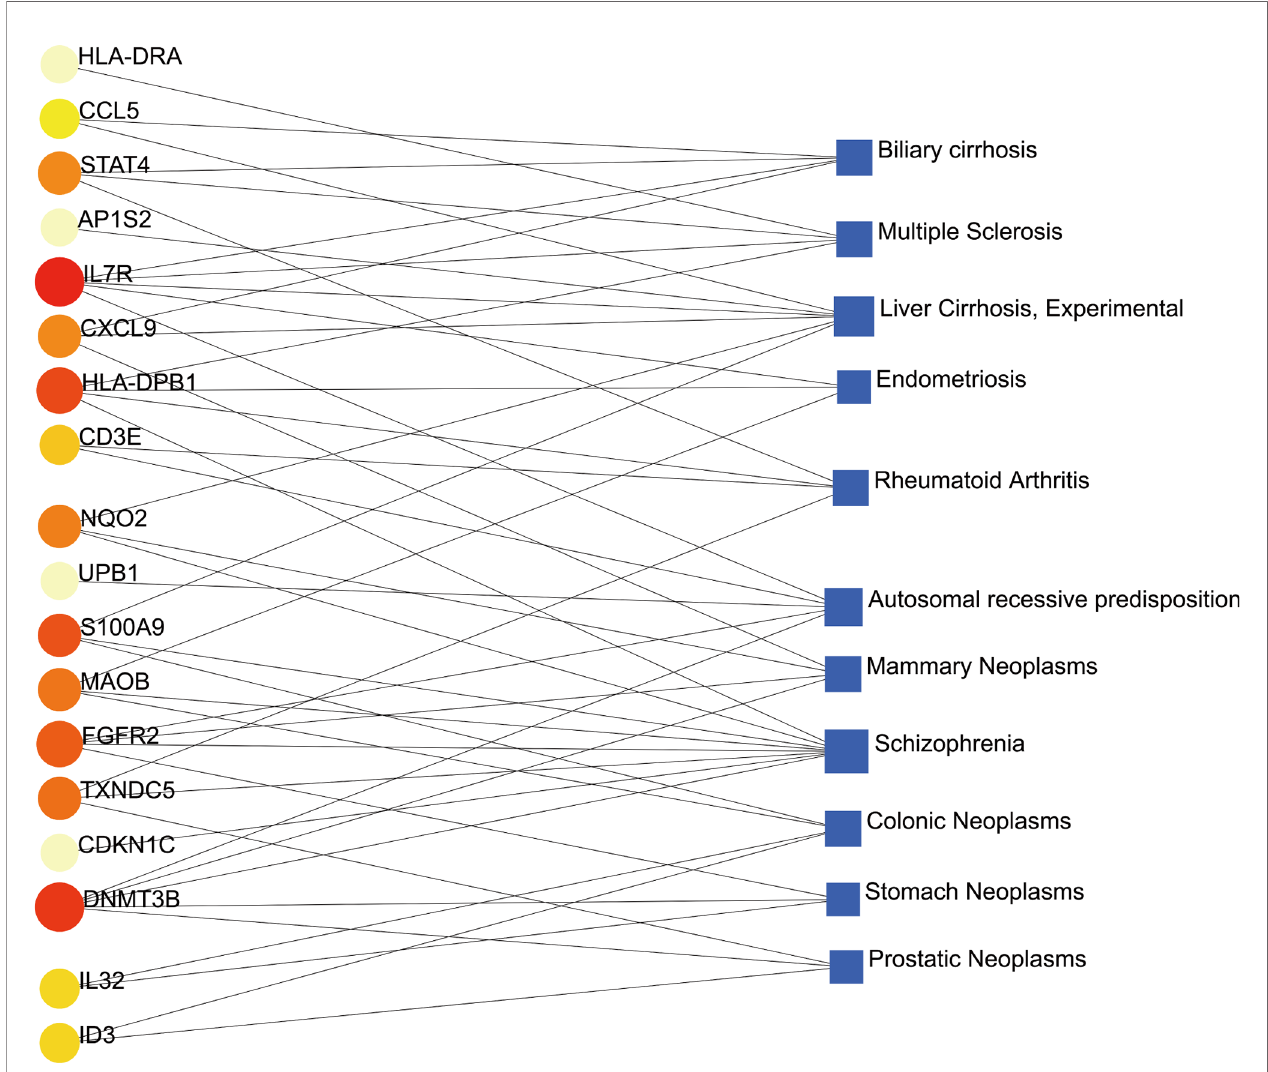
FIGURE 9 | The gene-disease association network represents diseases associated with common DEGs. The disease represented by the square node and also its subsequent gene symbols are de fi ned by the circular